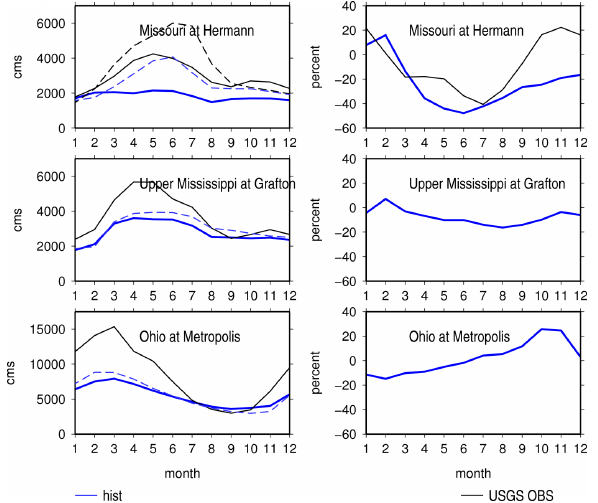
Figure 8: long term simulated time series of historical and future (B1) mean annual regulated and natural flow for the 2 three regions. 3 Fig. 7. long-term simulated time series of historical and future (B1) 4 mean annual regulated and natural flow for the three